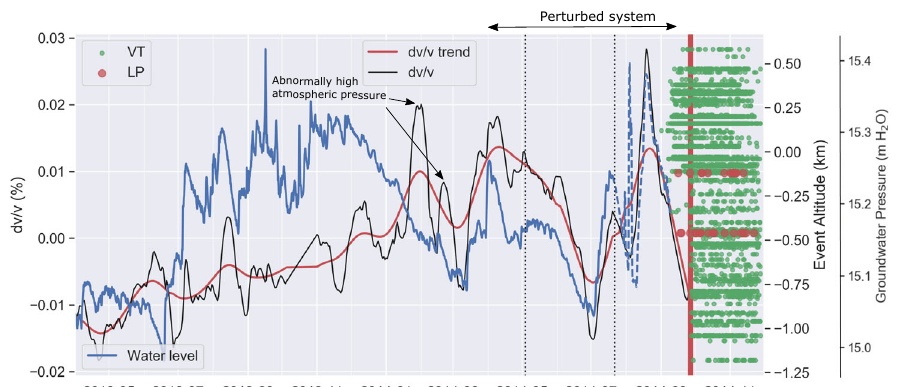
Fig. 3 | Seismic velocity combined with complementary observations. dv/v is estimated using daily ACF at station ONTA and inverting for a continuous velocity change time as in Brenguier et al. 30 with a weighting coef fi cient of 100,000 (black line). The dv/v curve has been corrected for external perturbations due to rain and snow accumulation, following Wang et al. 22 . We have also smoothed the dv/v curve usingaHodrickPrescott fi lter 63 withafactorof10,000(redline).Thewaterleveldata (blue line) are from Koizumi et al. 41 . The sensor is located between MKO and MTB